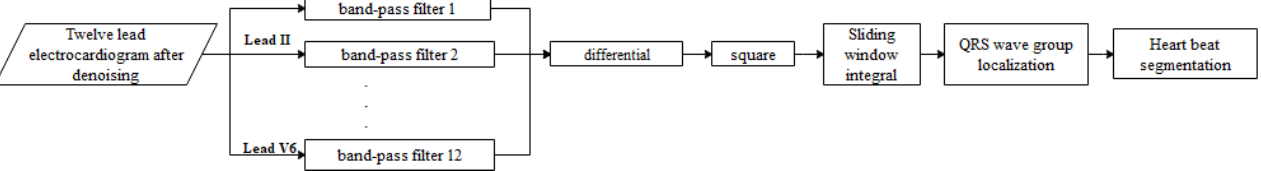
Figure 5. Block diagram of the QRS complex location and beat segmentation algorithm, with separate leads [14].